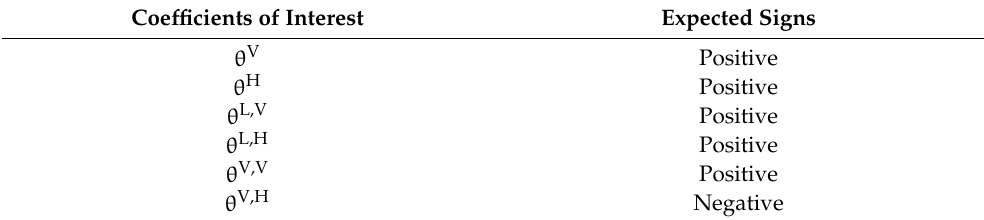
Table 1. Expected signs of coefficients of interest.